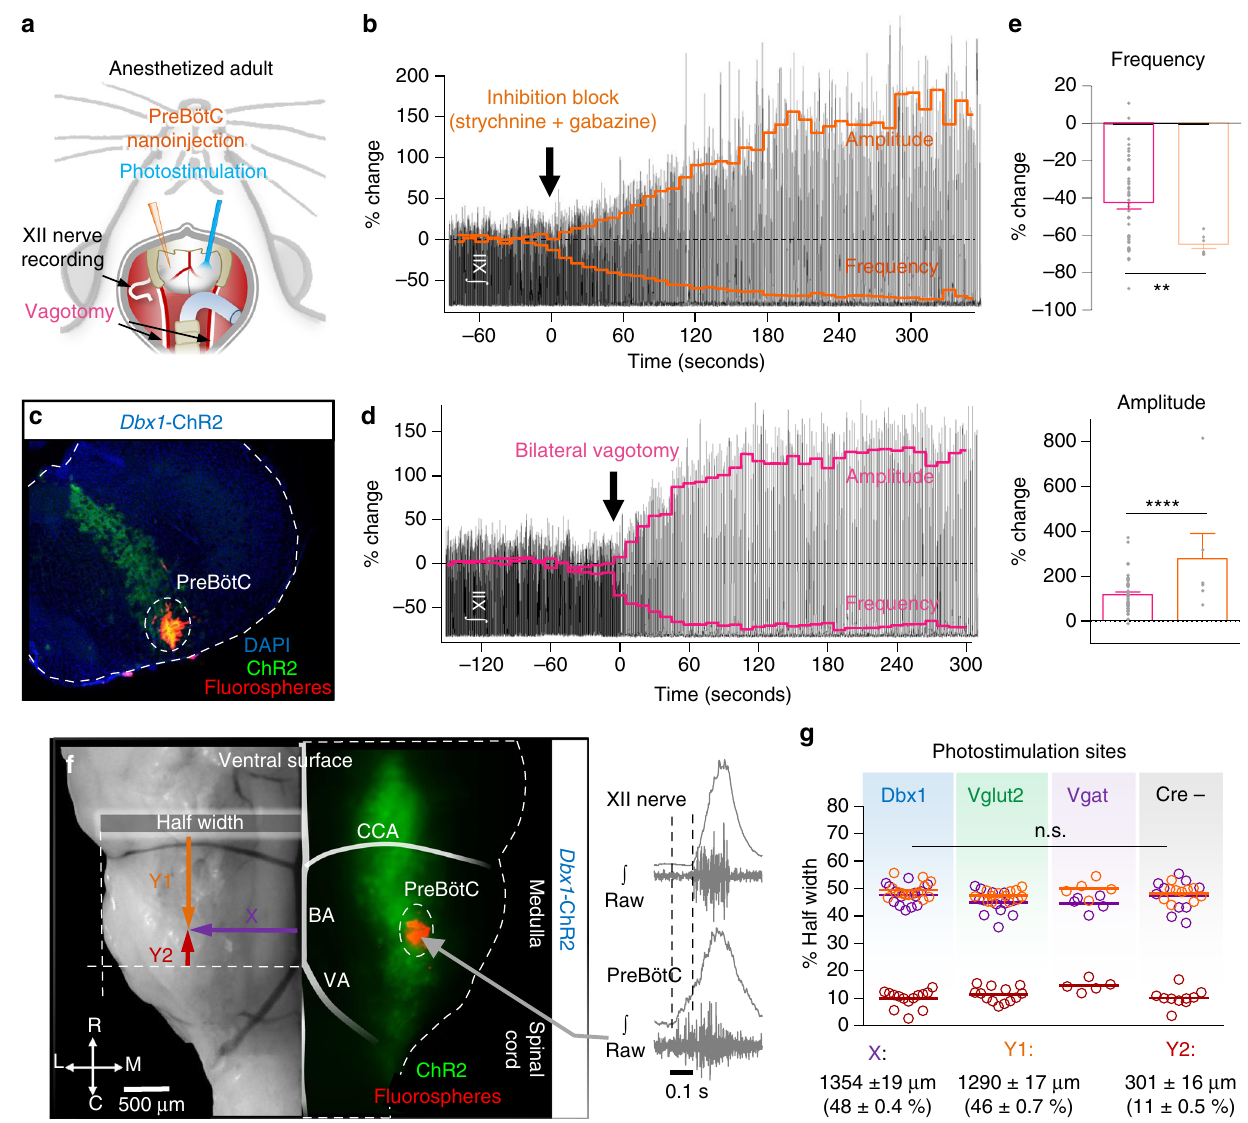
Fig. 6 Effects of preBötC sensory feedback inhibition on hypoglossal motor output in vivo. a Schematic of the surgical approach to access the ventral brainstem for bilateral preBötC nanoinjections, photostimulation, and vagotomy. b Representative trace of integrated hypoglossal (XII) nerve activity during bilateral injection of strychnine and gabazine (150 nl, 250 µ M each) with frequency and amplitude overlaid (10 s bins). c Example transverse hemisection showing injection site marked by fl ourospheres localized to the preBötC in a Dbx1 -ChR2 mouse. d Representative trace of XII activity during bilateral vagotomy with frequency and amplitude overlaid (10 s bins). e Quanti fi ed changes in frequency and amplitude ~5 min following vagotomy ( n = 47) and blockade of preBötC fast synaptic inhibition ( n = 6; unpaired two-tailed t -tests with Welch ’ s correction; ** p < 0.01, **** p < 0.0001). f Bright fi eld image (left) and Dbx1 -ChR2 fl uorescence (middle) of the ventral medulla showing the location of preBötC photostimulation relative to the basilar artery (BA), caudal cerebellar artery (CCA), and intersection of the vertebral arteries (VA). Example extracellular recording demonstrating pre-inspiratory activity relative to XII nerve activity at photostimulation sites (right). g Quanti fi ed coordinates of injected fl uorospheres (bottom) demonstrate that photostimulation sites were consistent across experimental groups (Dbx1, n = 14; Vglut2, n = 14; Vgat, n = 5; Cre-, n = 10; two-way ANOVA and Bonferonni ’ s post hoc test; n.s., not signi fi cant, p >